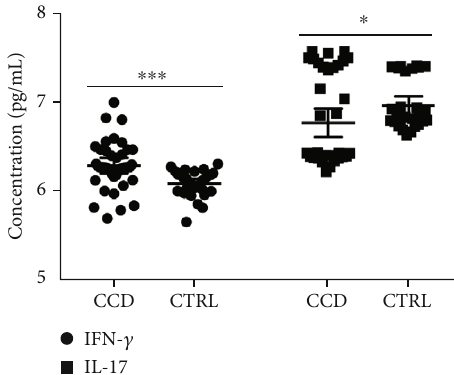
Figure 5: Cytokine production by THP-1 cells (macrophages) quanti fi ed in the supernatant by ELISA after 24h of stimulation with CCD or CTRL EVs. ( ∗ p = 0 : 0438 and ∗∗∗ p = 0 : 0002